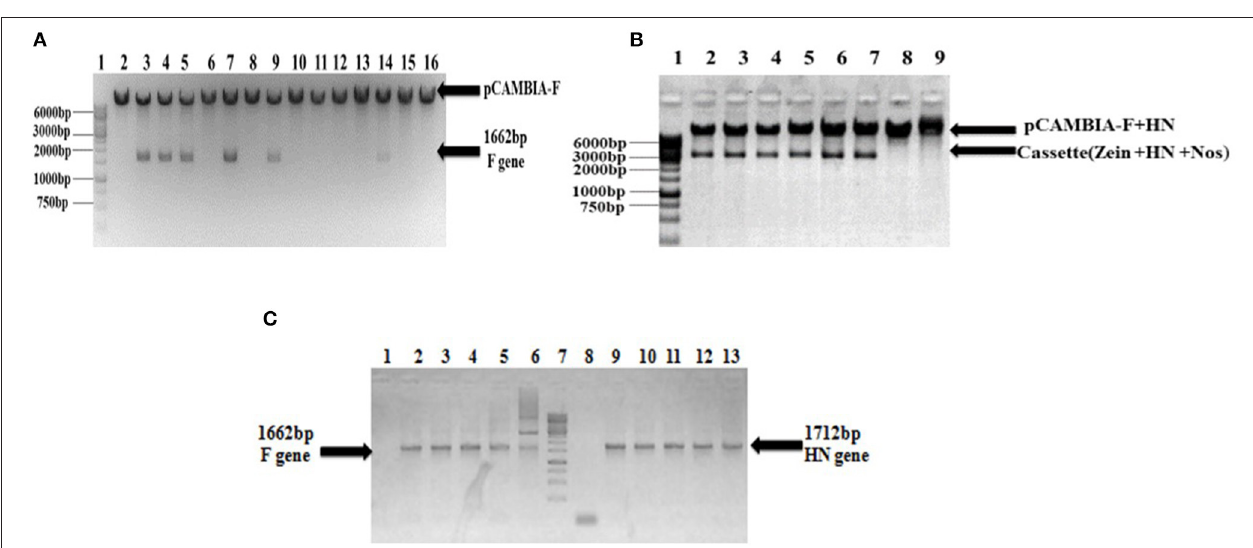
FIGURE 1 | Diagrammatic illustration of recombinant plasmid pCAMBIA F + HN. The immunogenic F gene was cloned in Nco1 and Bgl11 site under the regulation Cauliflower mosaic virus (CaMV) 35S promoter and HN gene was cloned in Sal1 and Kpn1 site of multiple cloning site with seed specific promoter.